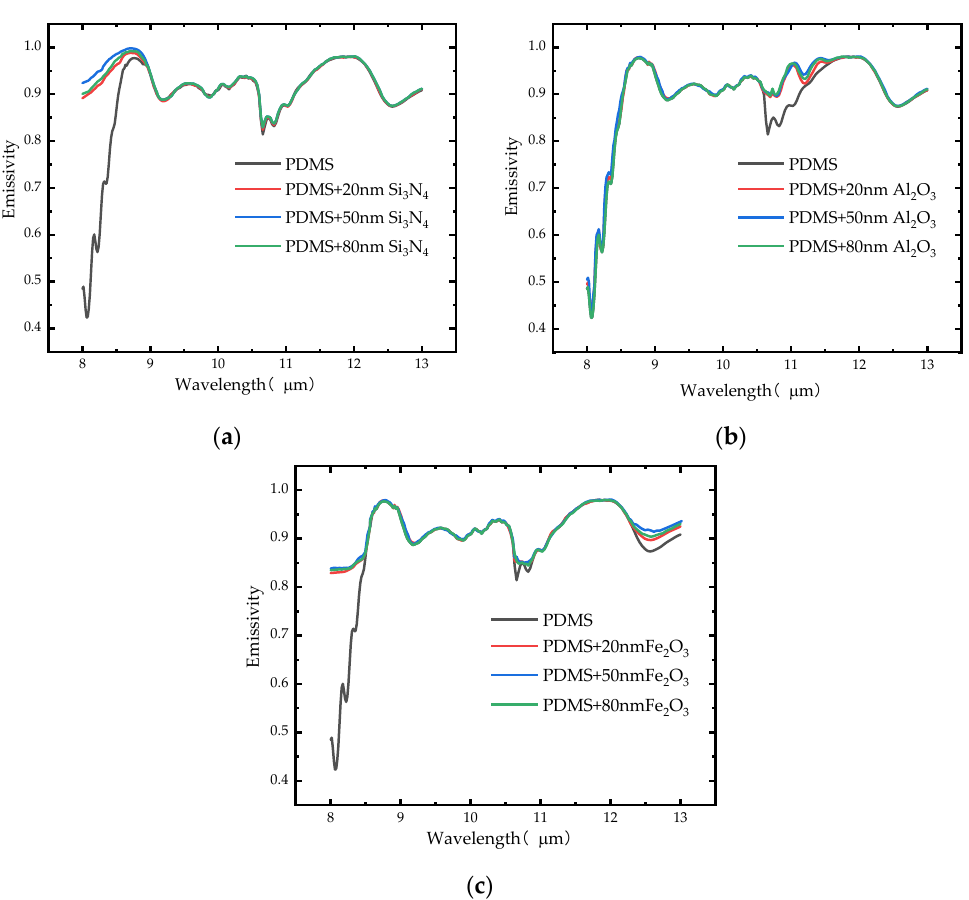
Figure 7. Effect of different diameter particles on emissivity of PDMS films: ( a ) influence of Si 3 N 4 particle diameter on emissivity; ( b ) influence of Al 2 O 3 particle diameter on emissivity; ( c ) influence of Fe 2 O 3 particle diameter on emissivity.